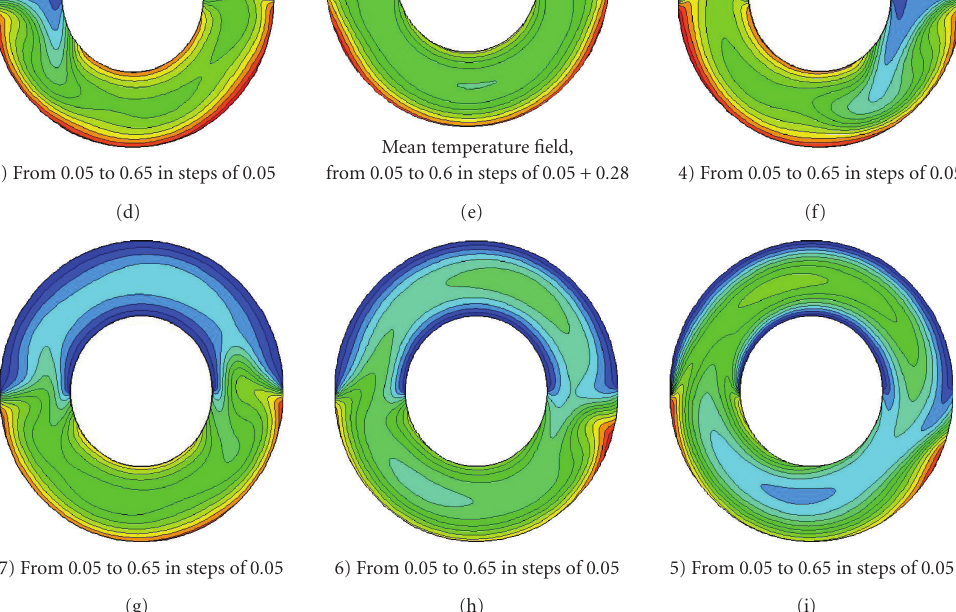
Figure 10). Relatively to the flow field, the recirculating re- gions at the entrance of the exchangers shift their location at each flow reversal occupying the first and third quadrants for counter-clockwise motion (see Figure 11 snapshots 8,1) and the second and fourth quadrants for clockwise motion (see Figure 11 snapshots 4,5). In the center of Figures 10 and 11, we also show the average temperature and stream function fields which are obtained by adding all the instan- taneous fields at each time step during the two quasiperi- odic flow evolutions showing reverse flows during the time [35 . 672,36 . 440] (see Figure 9(b)). The average fields are not exactly symmetrical with respect to the vertical centerplane because the flow evolution is not periodic. Videos 2 and